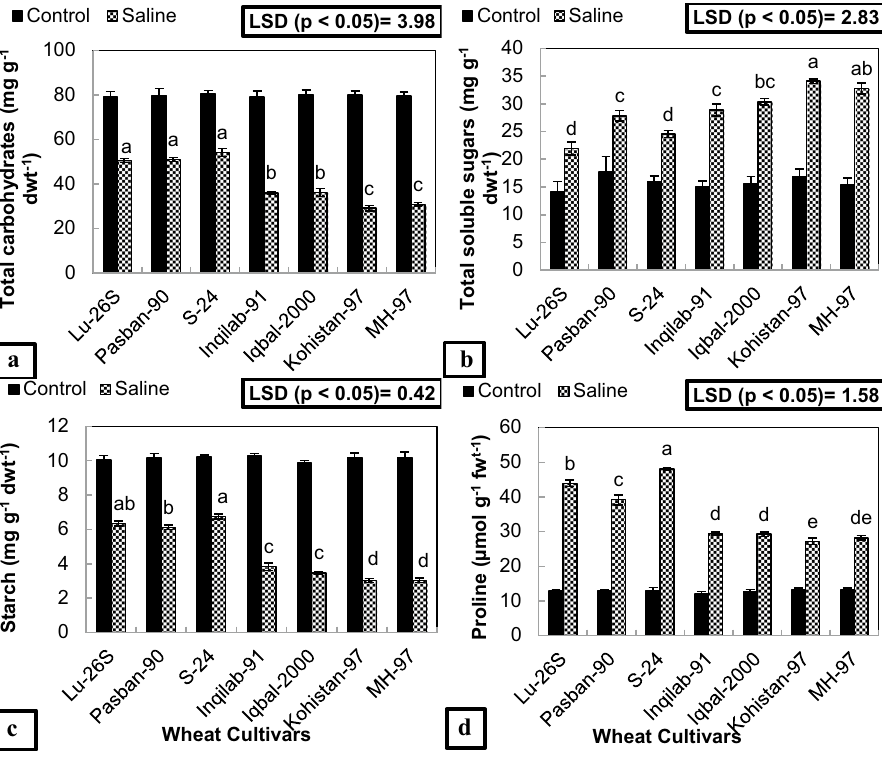
Figure 2. Concentration of organic osmolytes of seven selected salt tolerant and sensitive wheat cultivars subjected to 0 or 150 mM NaCl stress at adult stage. Different letters represent significant differences among the cultivars at ( p < 0.05) by LSD test. ( a ) Total carbohydrates, ( b ) Total soluble sugars, ( c ) Starch and ( d )